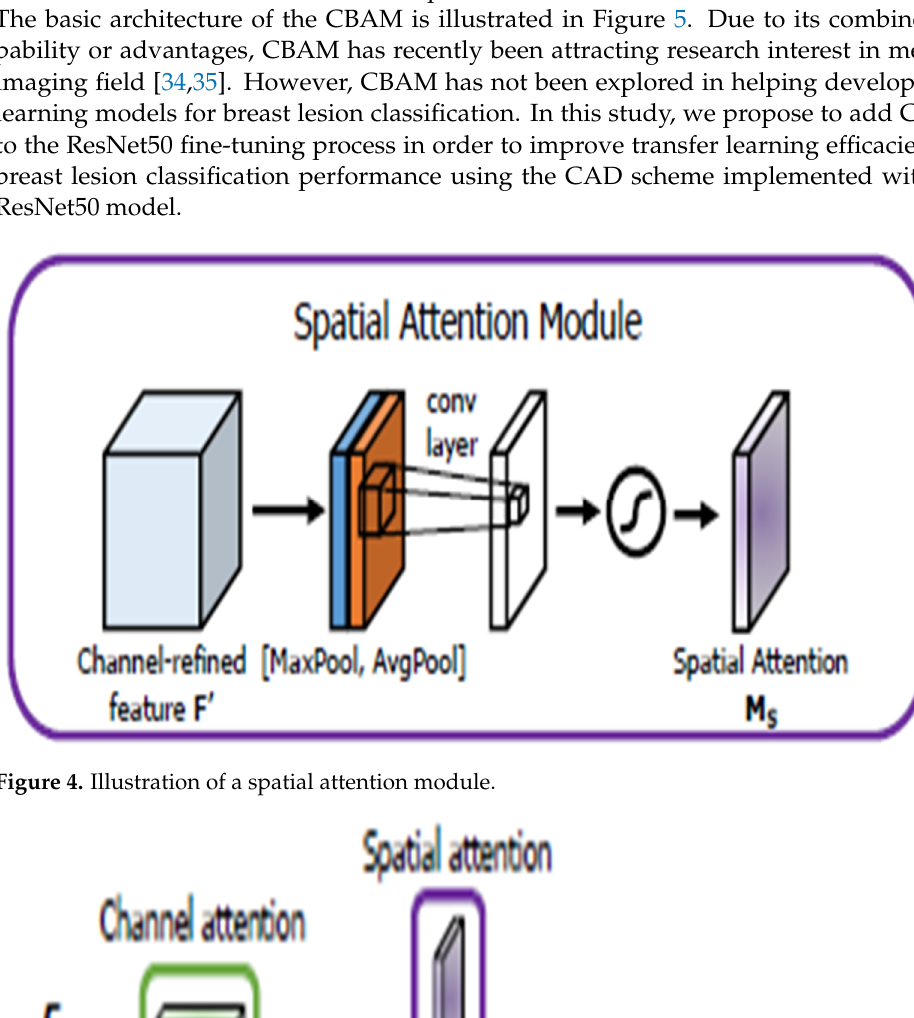
Figure 4. Illustration of a spatial attention module.